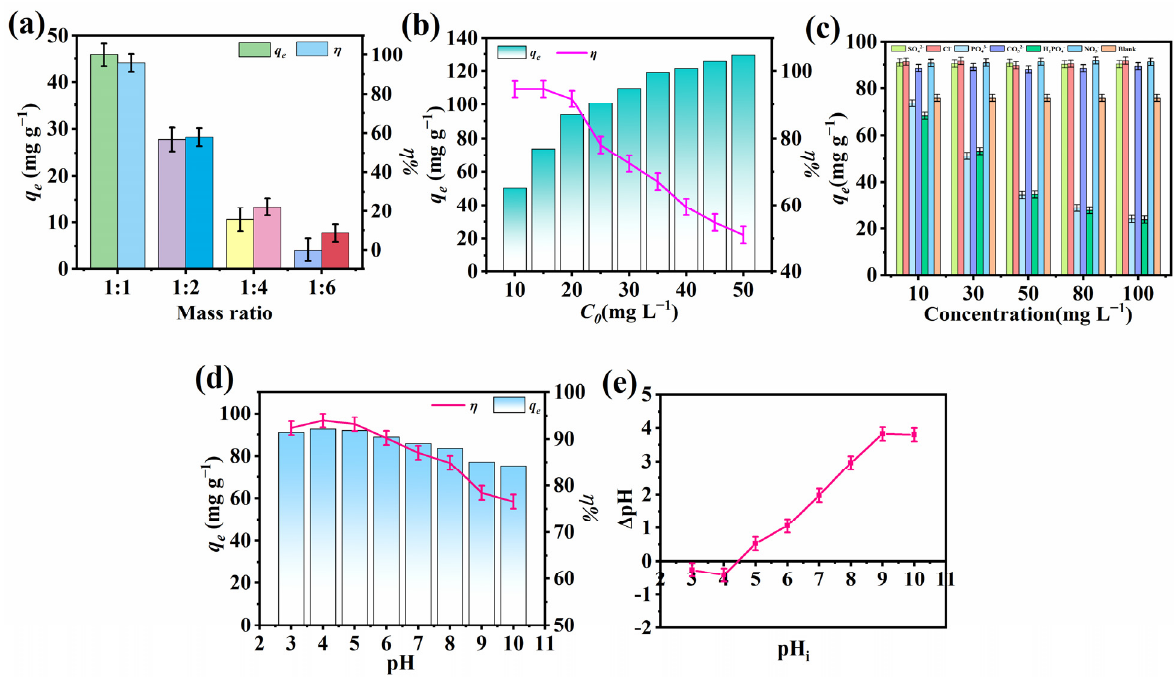
Figure 1. Effect on fluoride removal of ( a ) molar ratio of precursors, ( b ) initial fluoride concentration, ( c ) co-existing ions, ( d ) pH, ( e ) analysis of the zero-point charge (pH zpc ) for fl uoride removal.